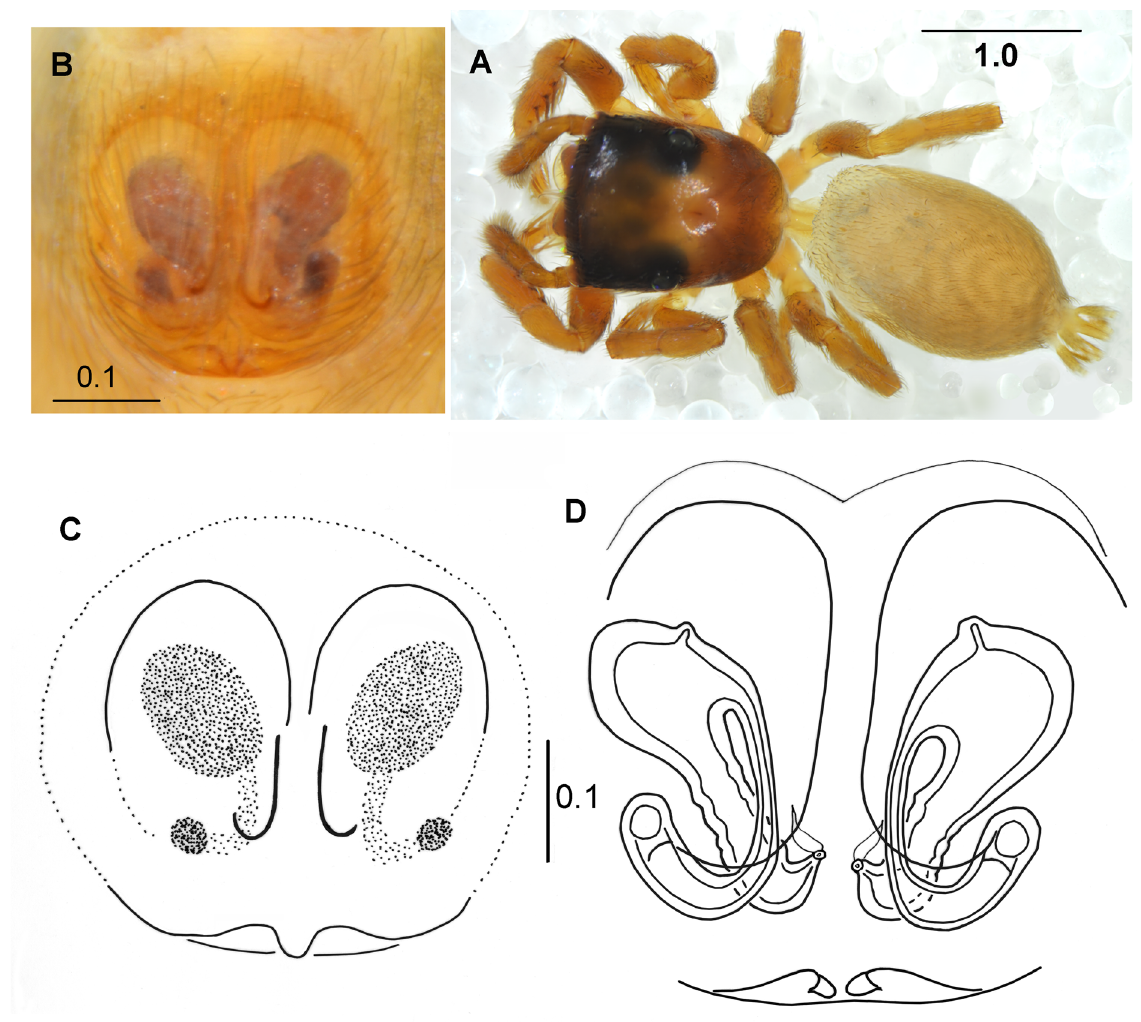
Fig. 15. Detalik cavally sp. nov., holotype, ♀ (MNHN). A . Habitus, dorsal view. B–C . Epigyne. D . Internal structure of